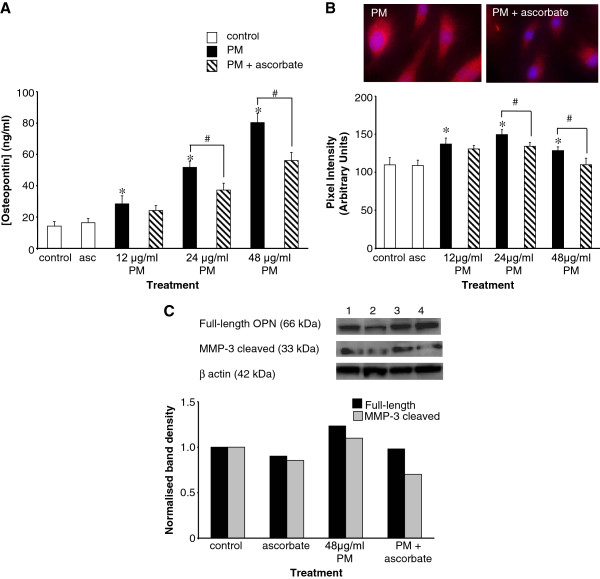
 Induction of osteopontin expression by PM is oxidative stress-dependent.A, ascorbate pre-treatment (200 μM for 5 h) prior to a 24-hour exposure to 12, 24, or 48 μg/ml PM reduced osteopontin secretion compared to cells exposed to PM alone. Data are presented as mean ± S.D. osteopontin concentrations, as detected by electrochemiluminescence. N = 6 in each case. B, similar to the secretion studies, immunocytochemistry showed that ascorbate pre-treatment blunted the increase in osteopontin immunostaining caused by PM exposure. Graphical data are mean pixel intensities from 10 cells at each concentration. In A and B, *p < 0.05 compared to controls and #p < 0.05 compared to PM alone. C, Western blotting studies detected the presence of bands at 66 kDa and 33 kDa representing full-length and MMP-3 cleaved osteopontin, respectively. Ascorbate pre-treatment caused a reduction in the PM-induced elevation of osteopontin protein levels, which was most prominent in the MMP-3 cleaved form. Lane one, DMSO; lane two, ascorbate alone; lane three, PM; and lane four, PM with ascorbate pre-treatment. Graphical data are band densities obtained by densitometric analysis of Western blots.